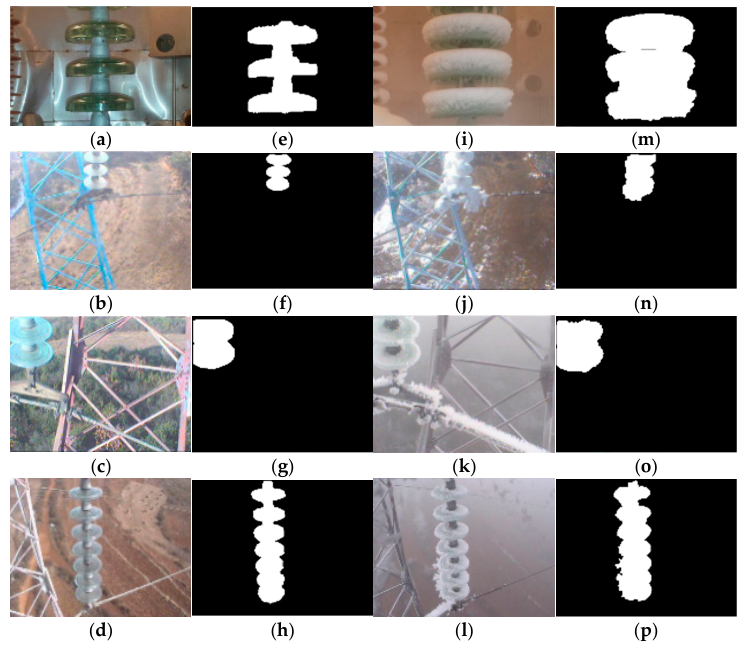
Figure 8. Insulators without ice ( a – d ) and their GrabCut segmentation results ( e – h ), and insulators with ice ( i – l ) and their GrabCut segmentation results ( m – p ).